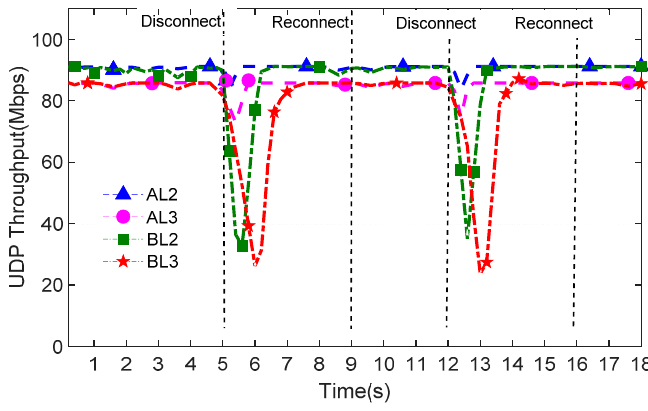
Figure 9. Instant throughput over time.